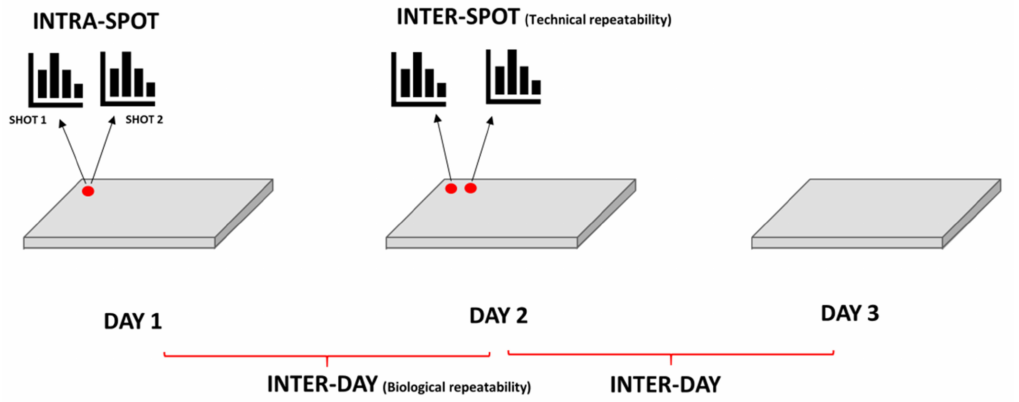
Figure 2. Graphic representation of 12 replicates spectra for each isolate: 2 spectra are acquired per spot; 2 spots analyzed each day and compared for 3 consecutive